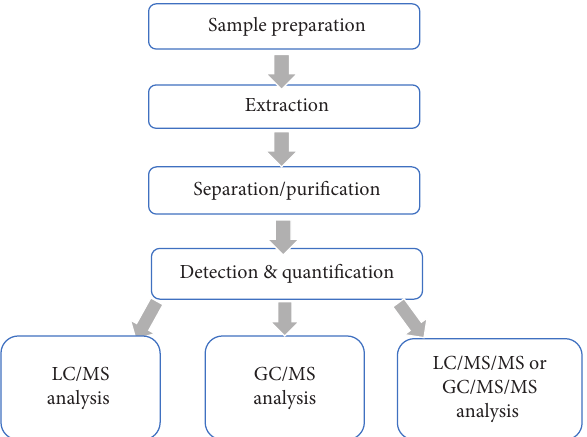
Figure 2: Typical analytical procedure for the measurement of emerging pollutants in aqueous